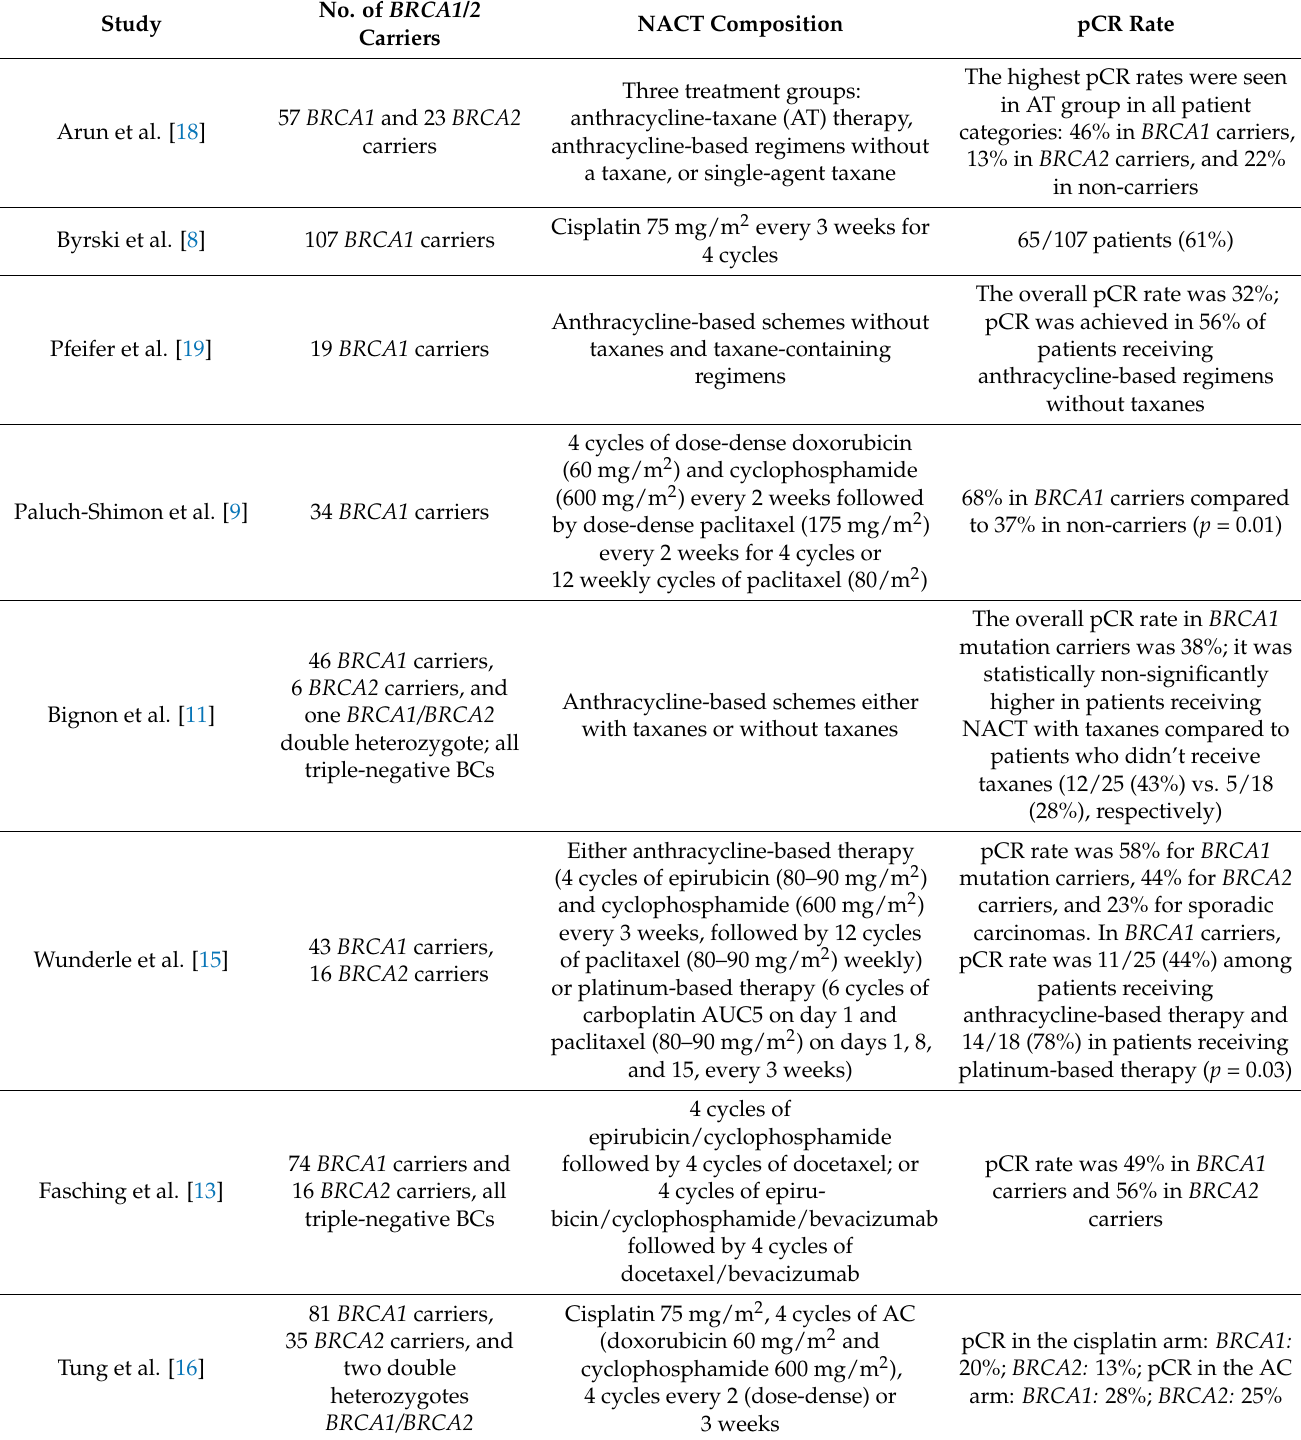
Table 4. Major studies evaluating pCR rate in BC patients with BRCA1 germ-line